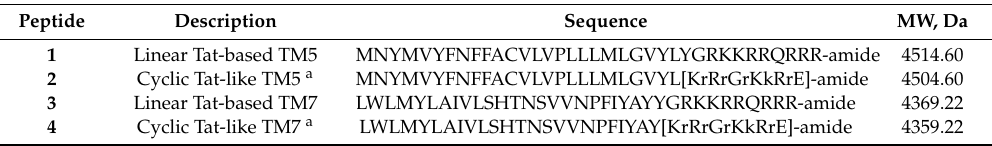
Table 1. Peptides used in this study.